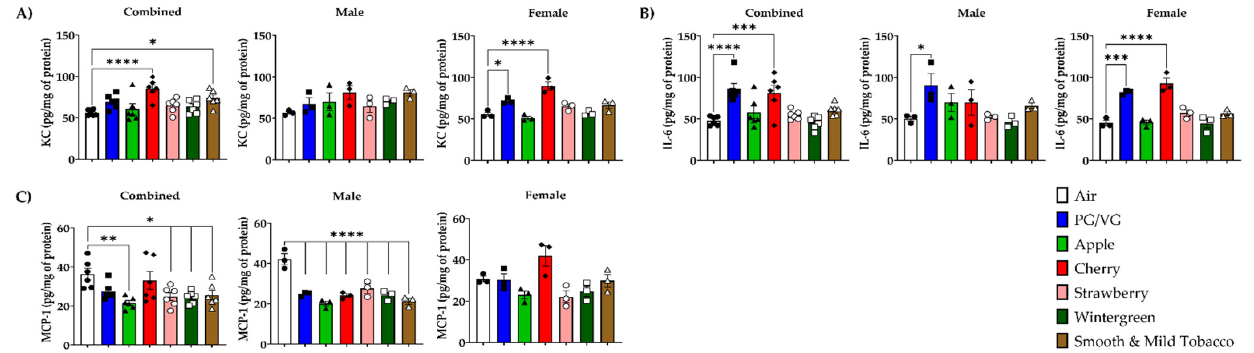
Figure 3. Sex-dependent effects of acute flavored e-cigarette exposure on pro-inflammatory cytokines/chemokine release in lung homogenate. Mice were exposed to air, PG/VG, and e-liquid flavors “Apple”, “Cherry”, “Strawberry”, “Wintergreen”, and “Smooth & Mild Tobacco” for 3 days for 1 h per day. Mice were sacrificed twenty-four hours after the final exposure. Pro-inflammatory cytokines/chemokines were measured in lung homogenate. ( A ) KC levels, ( B ) IL-6 levels, ( C ) MCP-1 levels. Data are shown as mean ± SEM with individual data points represented by the following symbols: Air (black circles), PG/VG (black squares), Apple (black triangles), Cherry (black diamonds), Strawberry (white circles), Wintergreen (white squares), Smooth & Mild Tobacco (white triangles), with * p < 0.05, ** p < 0.01, *** p < 0.001, and **** p < 0.0001 vs. air controls. n = 6 for combined groups and n = 3 for male- and female-only